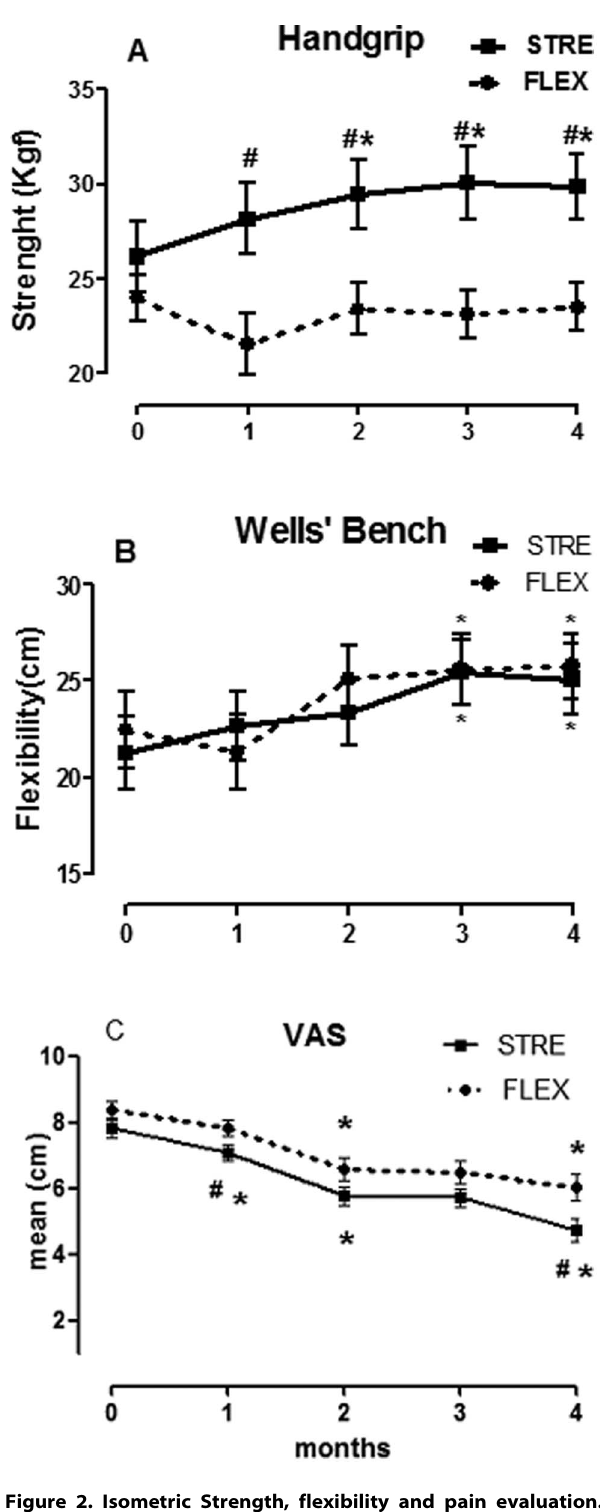
Figure 2. Isometric Strength, flexibility and pain evaluation. Mean and standard error of measures of strength (handgrip) (A), flexibility (Wells’ Bench) (B), Visual-Analogical Scale (VAS) (C), STRE: Resistance Exercise, FLEX: Flexibility Exercise. Wilcoxon Test: intra-group comparison (*), ANOVA: inter-group comparison ( # ), *p # 0.05. ANOVA: analysis of variance for repeated measures. Post-hoc Bonferroni’s